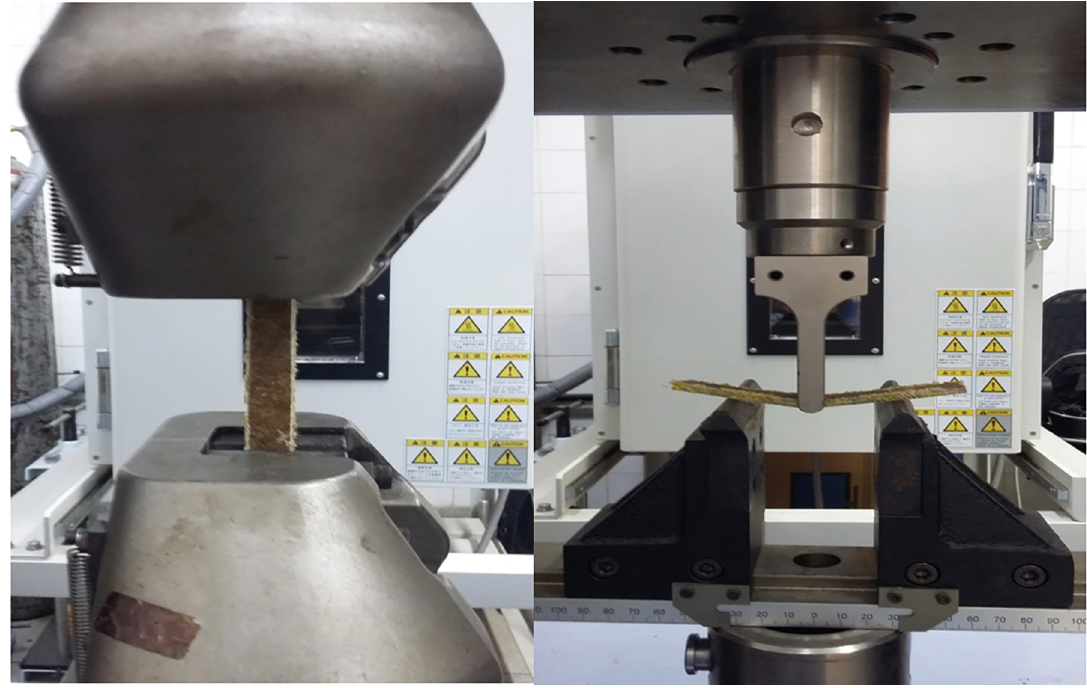
Figure 2. Tensile and flexural test set-up Table 2. Tensile and three-point bending test results of Curaua fibers composite Maximum Tensile Fiber content (%) Strength (MPa)